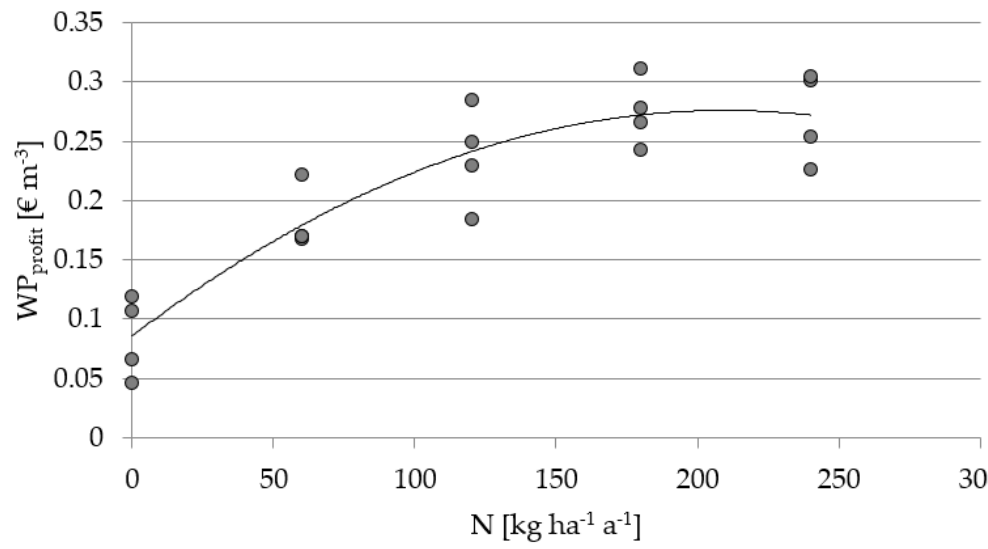
Figure 3. Relationship between monetary-based water productivity (WP profit ) and fertilizer treat- ments (N) with quadratic crop yield response function estimated in the experiment (Equation 4) for the three years.